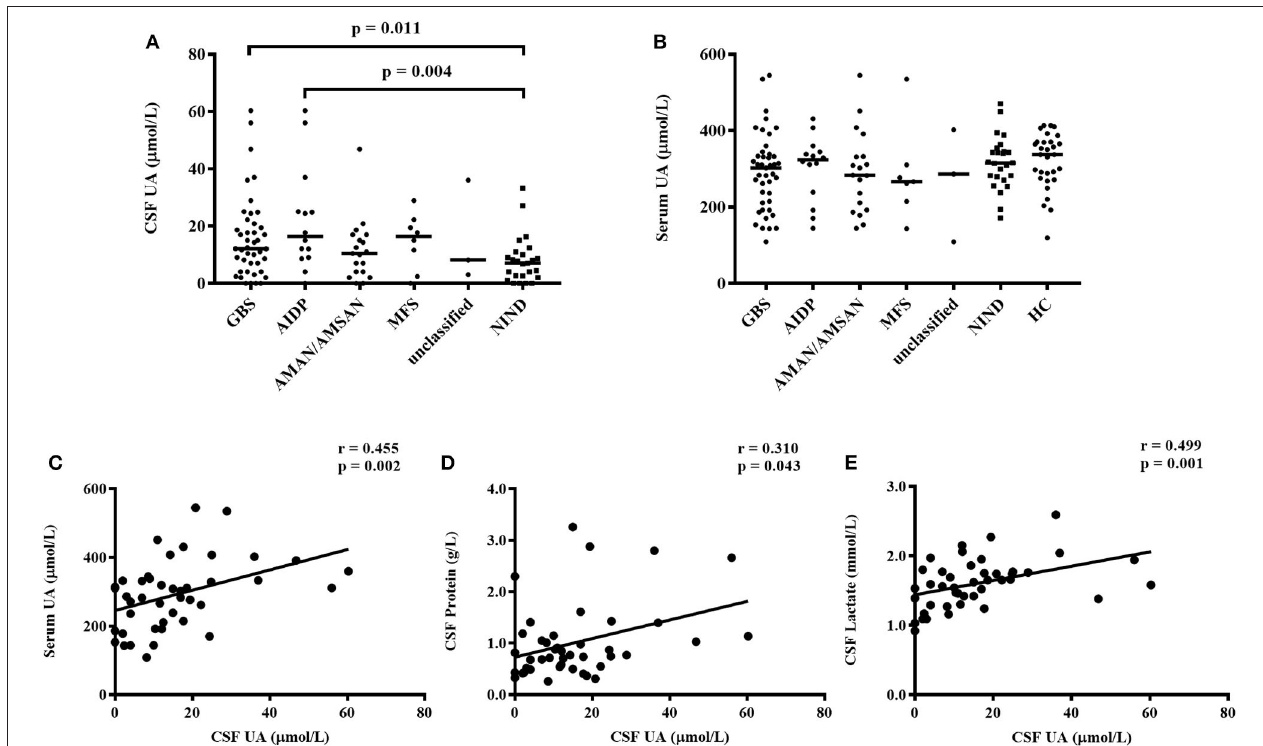
FIGURE 1 | CSF and serum UA levels in subtypes of GBS, NIND, and HC. (A) CSF UA levels were increased significantly in patients with GBS ( p = 0.011) and AIDP subtype ( p = 0.004) compared with NIND. (B) The difference of serum UA levels among patients with GBS, NIND, and HC were not statistically significant ( p = 0.175). (C) Correlation between levels of CSF UA and serum UA, adjusted p = 0.022 after the Bonferroni correction. (D) Correlation between CSF UA and CSF protein, adjusted p = 0.473 after the Bonferroni correction. (E) Correlation between CSF UA and CSF lactate, adjusted p = 0.011 after the Bonferroni correction. GBS, Guillain–Barré syndrome; AIDP, acute inflammatory demyelinating polyneuropathy; AMAN, acute motor axonal neuropathy; AMSAN, acute motor and sensory axonal neuropathy; MFS, Miller Fisher syndrome; NIND, non-inflammatory neurological disorders; HC, healthy control; CSF, cerebrospinal fluid; UA, uric